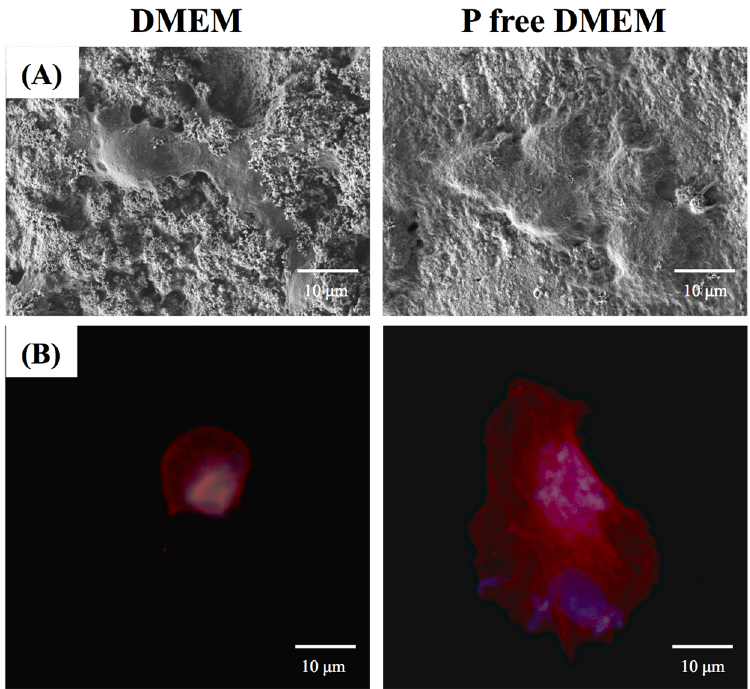
Figure 6. ( A ) SEM and ( B ) immunofluorescence images of hDPCs seeding on CS with two DMEM for 3